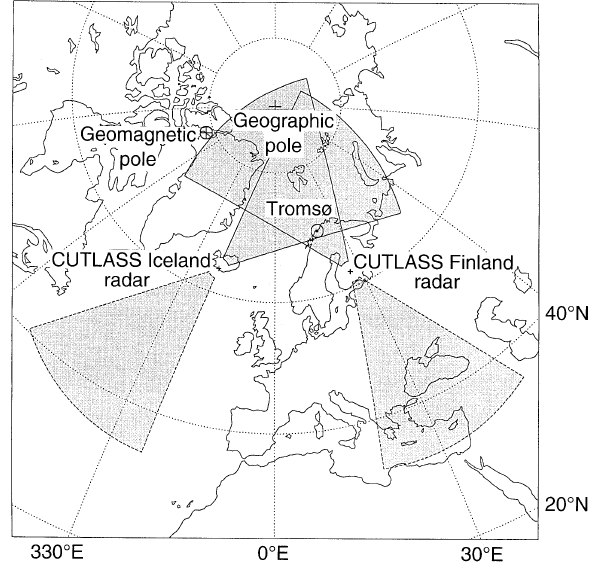
Fig. 2. The locations of the front and rear fields-of-view of the CUTLASS Finland and Iceland radars assuming a maximum range of 3555 km. The location of Troms (cid:249) , Norway, is also indicated, the site of the EISCAT incoherent radar, ionospheric heating facility, and